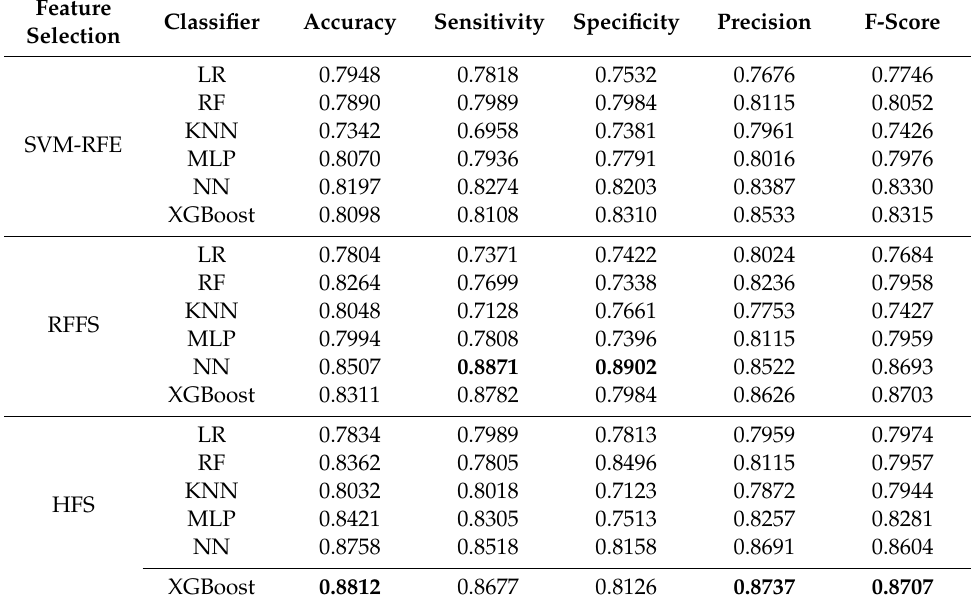
Table 2. Evaluation results of the prediction models in the Korea National Health and Nutrition Examination Survey